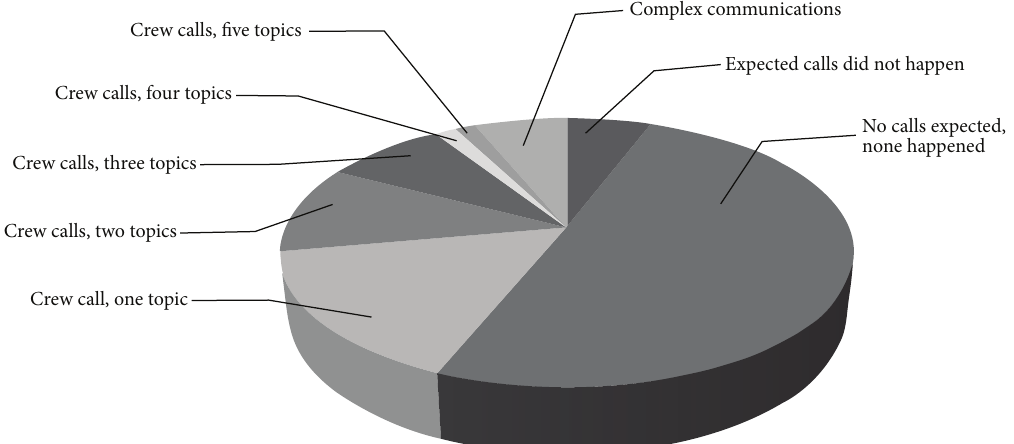
Figure 5: Crew calls statistics ( 𝑁 = 144 ).